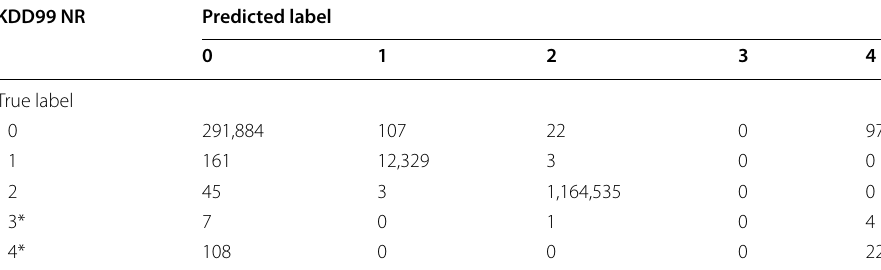
Table 13 Confusion matrix: KDD99 NR KDD99 NR